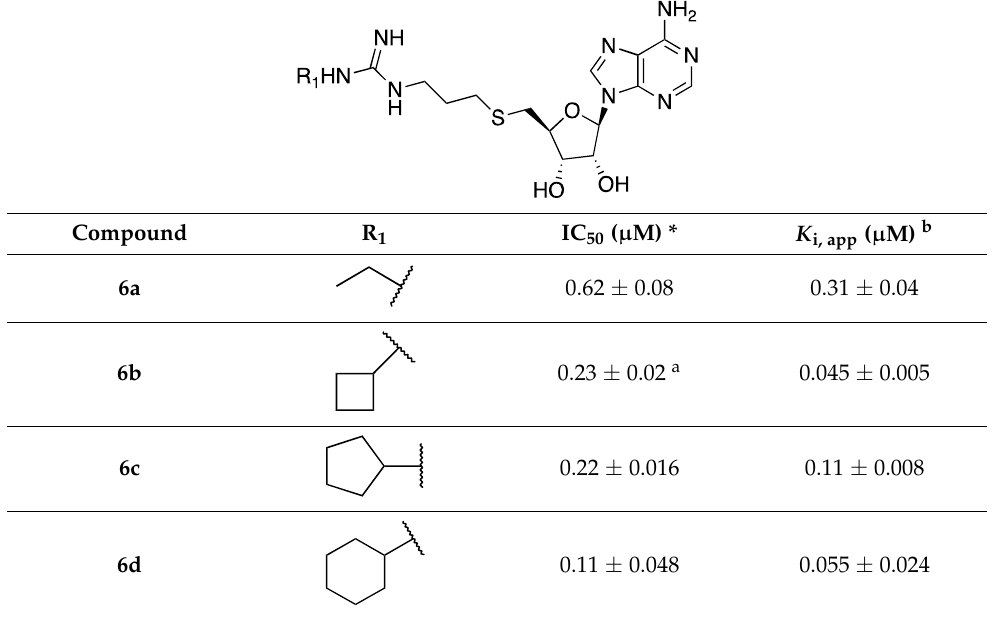
Table 1. SAR of synthesized compounds 6a–6n .